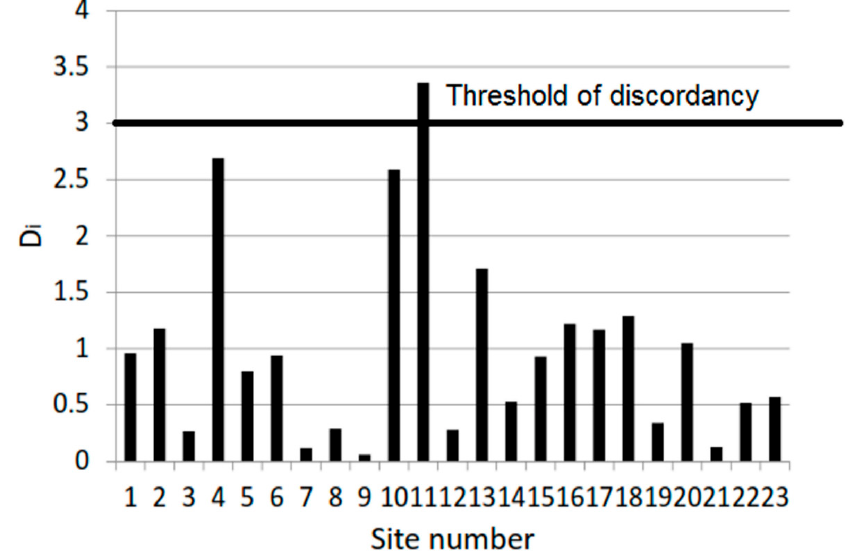
Figure 2. Discordancy measure (Di) of the different gauge sites.